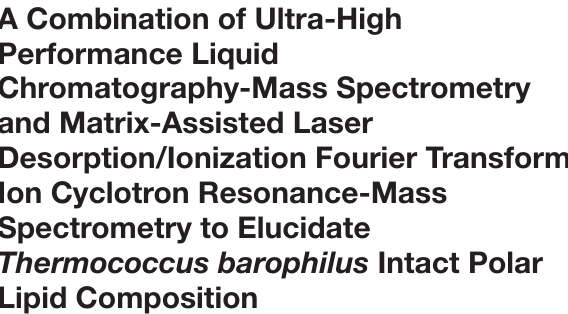
( Supplementary Figure 11 ) and apolar